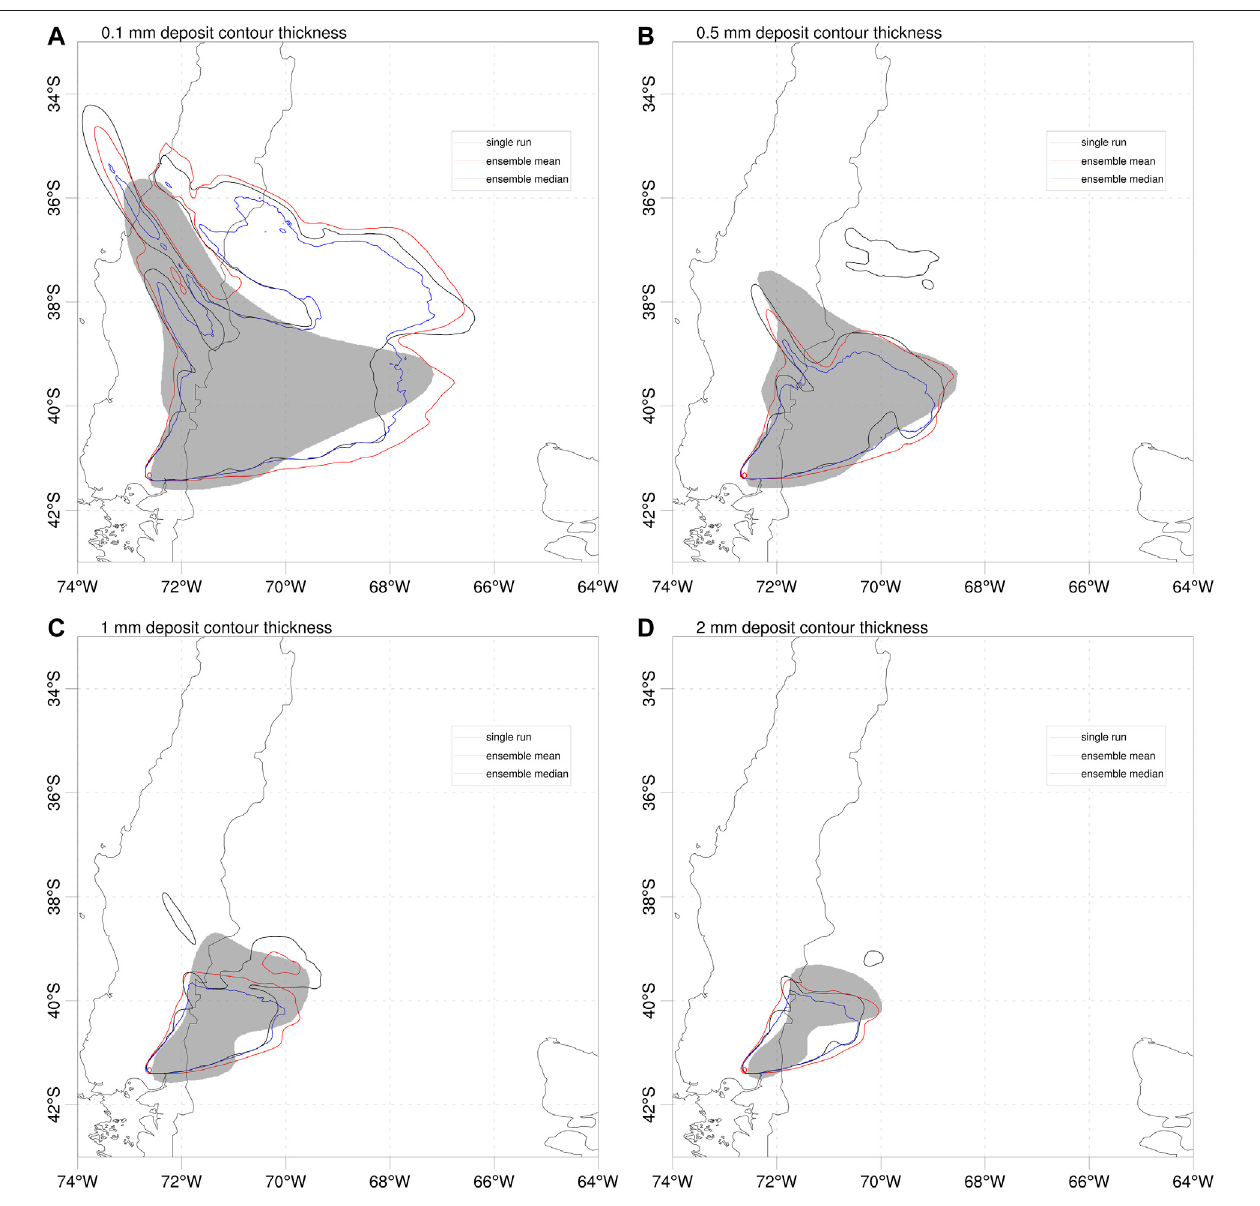
FIGURE7| Validation of Calbuco deterministic forecasts using deposit isopach contours of 0.1, 0.5, 1, and 2 mm. Model results for single-run (black line), ensemble mean (red line) and ensemble median (blue line). Grey- fi lled areas show the corresponding isopachs estimated by Romero et al. (2016) from extrapolation of deposit point measurements. Red circle shows the location of Calbuco volcano. The resulting values of generalised categorical metrics are reported in Table 7 .